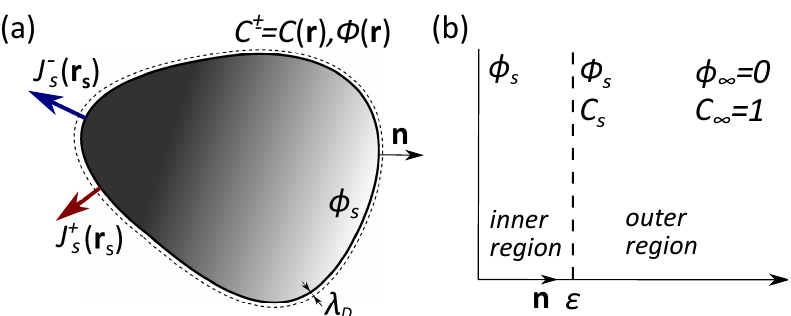
Figure 1. ( a ) Sketch of a catalytic microswimmer with a nonuniform release of ions; ( b ) Inner and outer regions for fields of concentration and electric